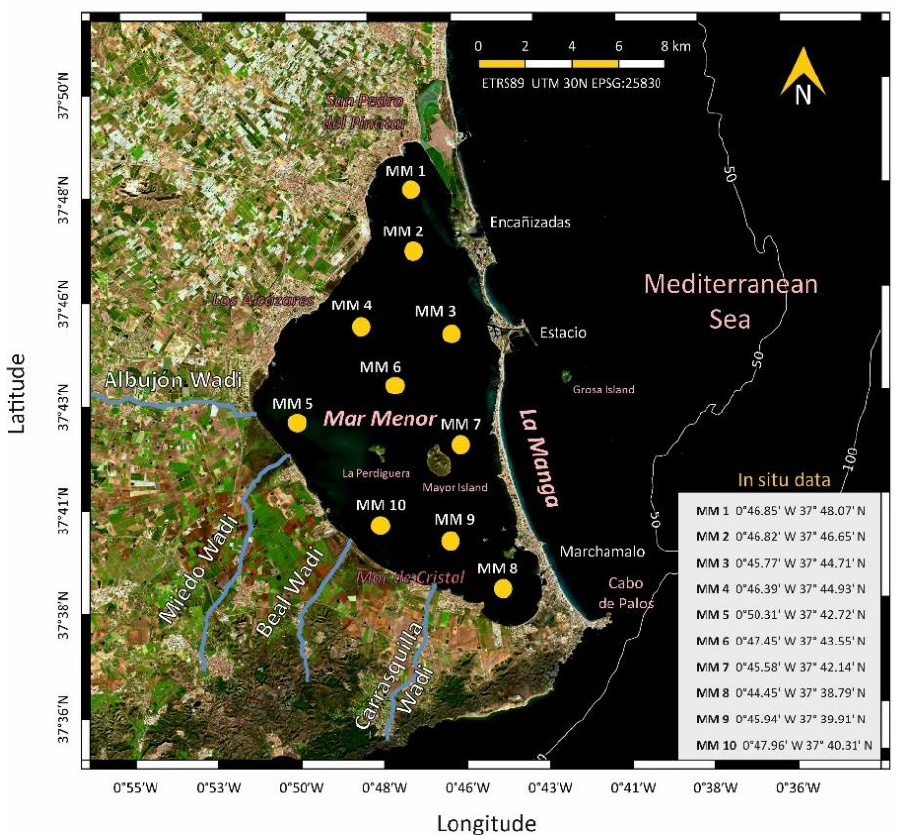
Figure 5. Control points for data collection during the four in situ campaigns carried out in March, July, August, and November 2021.